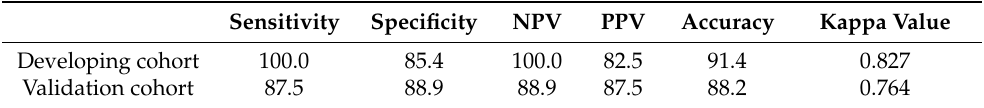
Figure 1. Receiver operator characteristic (ROC) curve for the prediction of ACT/chondrosarcoma with overall radiological score rates. The cutoff value determined by the ROC curve analysis was 31.3%. Table 5. The predictive powers of the overall radiological score compared with histological diagnoses in the developing cohort and validation